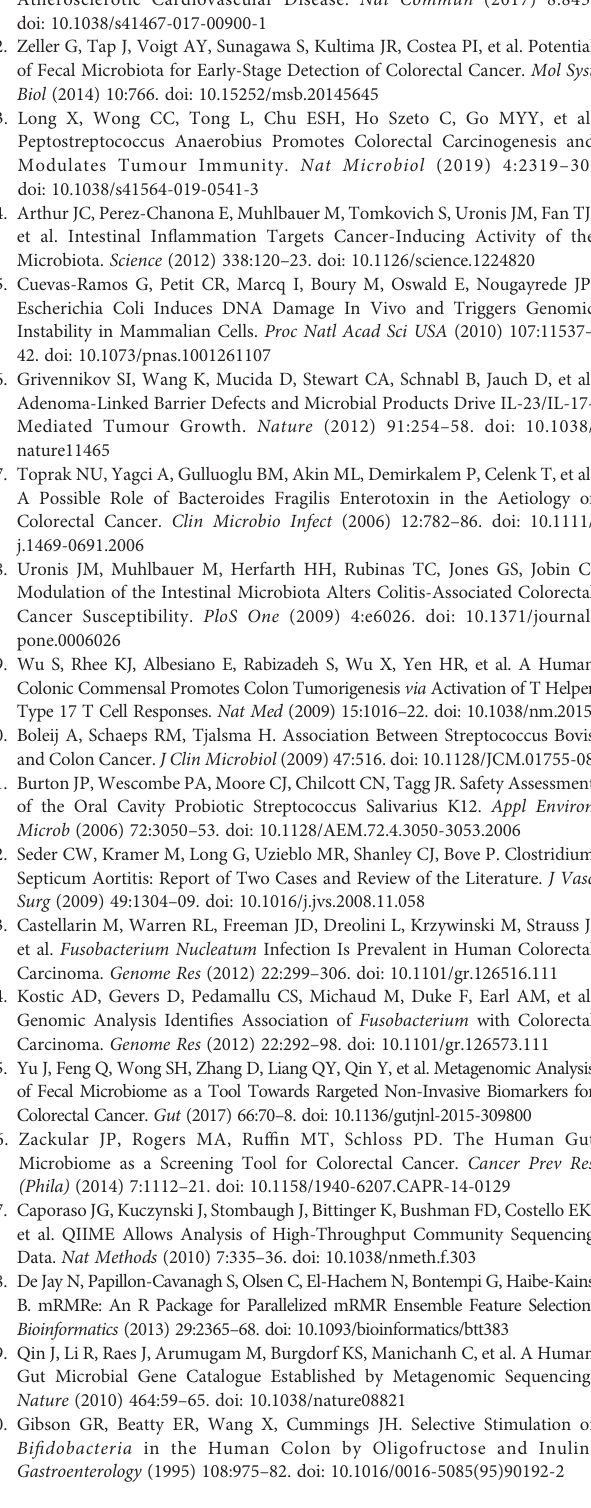
Supplementary Figure 4 | The distribution of two groups at phylum level (A) and family level (B)